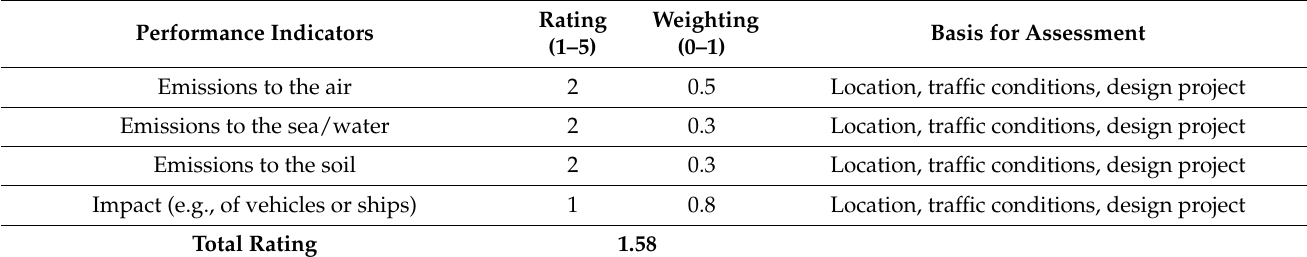
Table 11. Assessment of key performance indicators related to the environment.